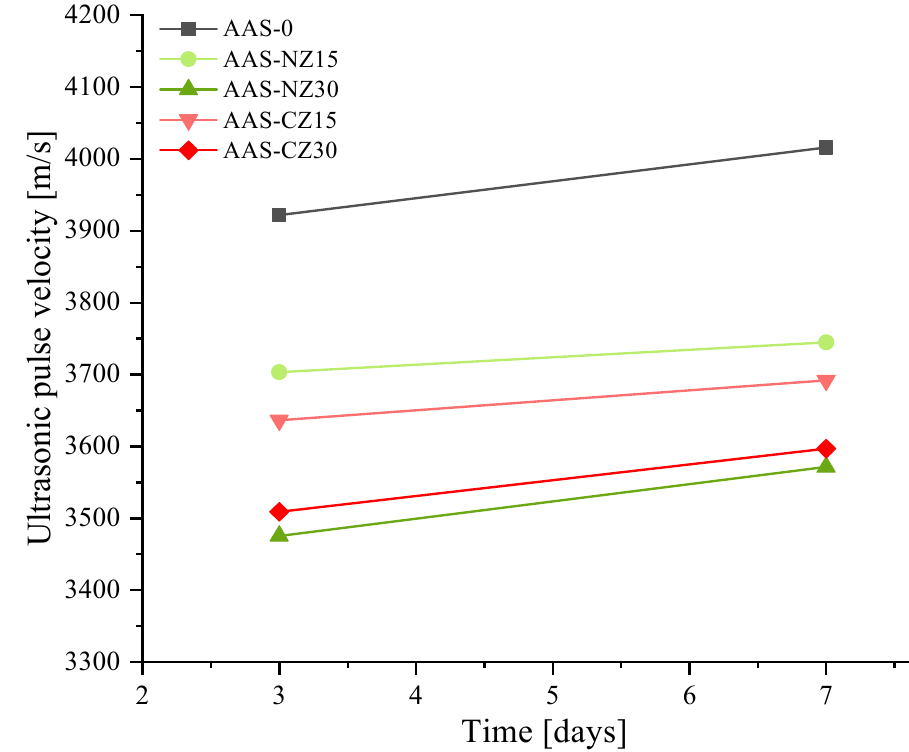
Figure 7. Ultrasonic pulse velocity values of the alkali-activated slag (AAS) mortars at 3 and 7 days.